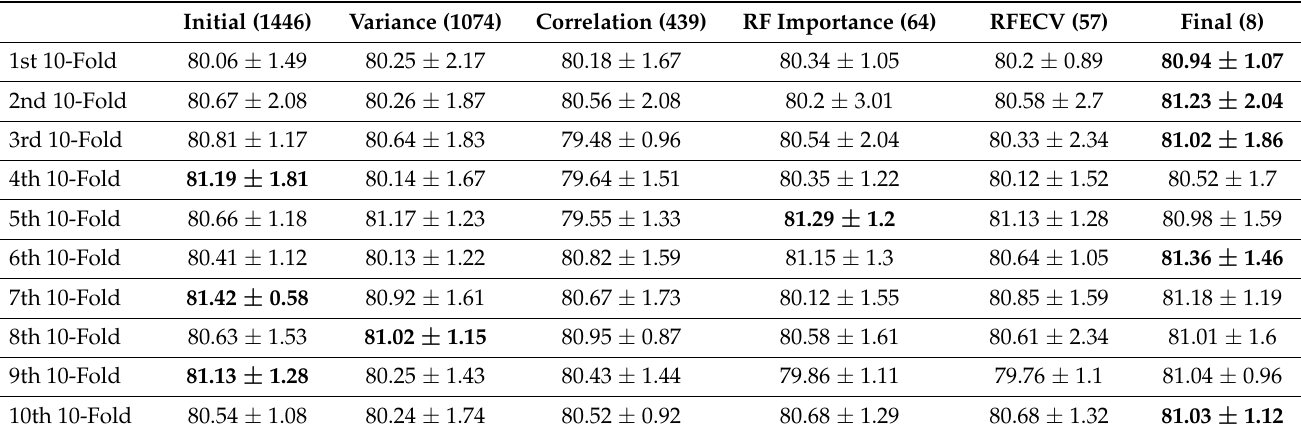
Table 1. Performance comparison of feature selection strategies under 10-time 10-fold cross-validation. The number of features for each set is given in parentheses. The best performance across each 10-fold CV is highlighted in bold.